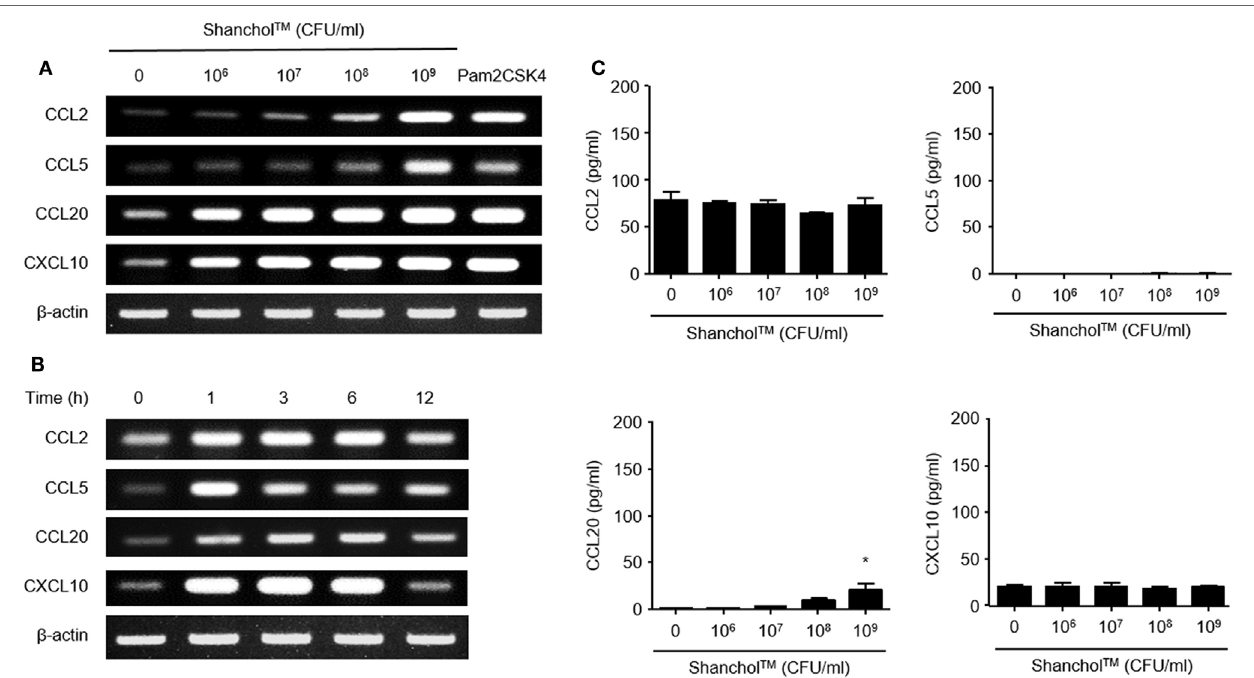
FigUre 1 | Shanchol ™ induces chemokine mRNA expression but hardly induces chemokine secretion in Caco-2 cells . Caco-2 cells were stimulated (a) with various concentration of Shanchol ™ (10 6 –10 9 CFU/ml) or Pam2CSK4 (1 µg/ml) for 3 h, or (B) with Shanchol ™ (10 8 CFU/ml) for various time periods. Total RNA was extracted and the mRNA expression levels of CCL2, CCL5, CCL20, and CXCL10 were determined by RT-PCR. Data shown are representative of three independent experiments. (c) Caco-2 cells were treated with various concentration of Shanchol ™ (10 6 –10 9 CFU/ml) for 24 h. Then, the cell culture supernatants were collected, and the concentrations of CCL2, CCL5, CCL20, and CXCL10 were determined by ELISA. Data shown are representative of three independent experiments. All results are expressed as mean ± SD of triplicate samples. The asterisk (*) indicates a statistically significant difference ( P < 0.05) compared with